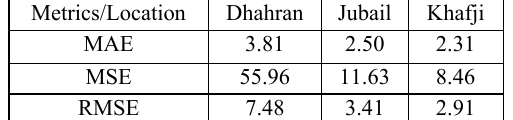
Figure 12. Forecasted and actual wind speeds of 2017, Jan & Feb, Jubail Case I.